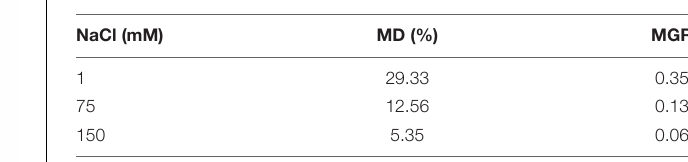
TABLE 2 | Mycorrhizal dependency (MD) and mycorrhizal growth response (MGR) of A. donax under three levels of NaCl